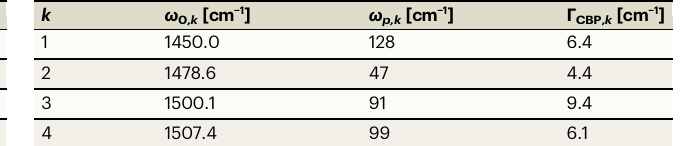
nanorod and CBP layer) was located in a homogeneous rectangular